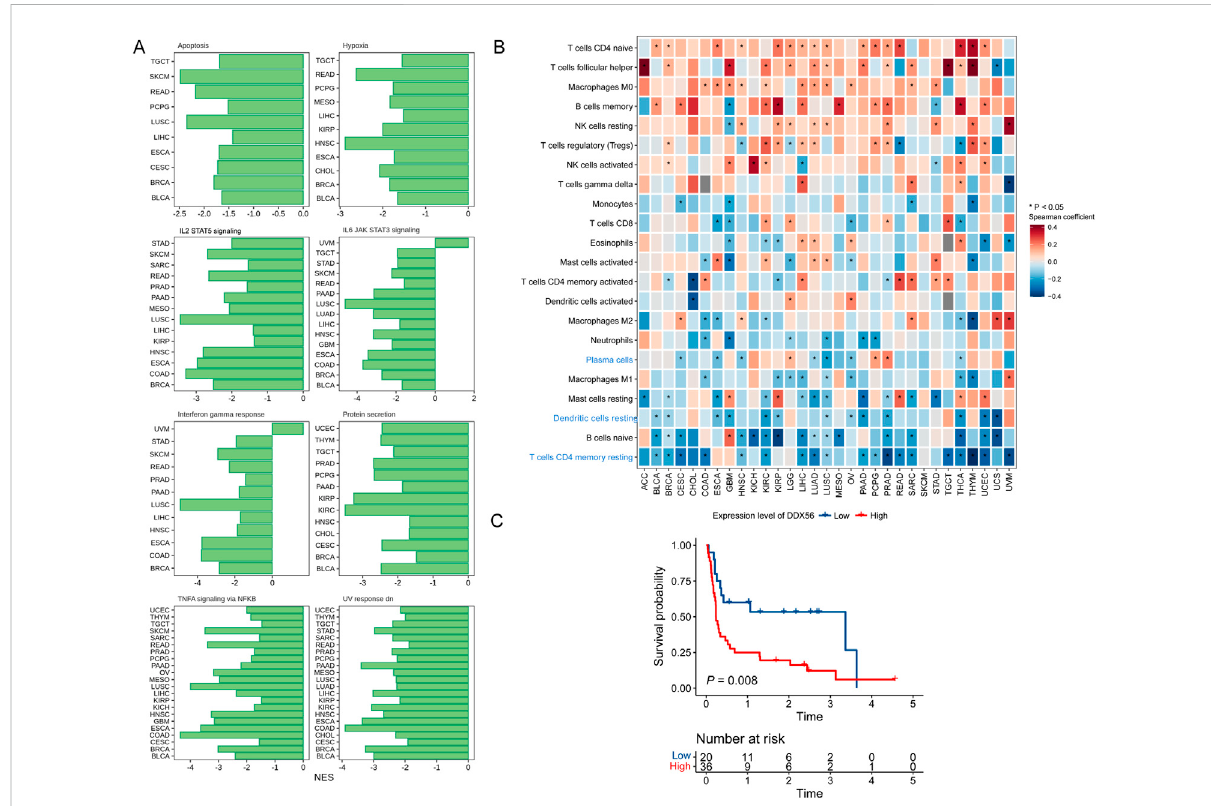
Relationships of DDX56 with tumor immune features. (A) GSEA enrichment results for DDX56 in multiple tumor types. Only pathways deemed signi fi cant enriched based on GSEA ( p < 0.05) are illustrated. (B) Heat map showing Spearman coef fi cients for DDX56 RNA expression and proportions of tumor-in fi ltrating immune cells. (C) Kaplan – Meier plots showing worse clinical outcome in immunotherapy cohort patients with higher expression of DDX56 . Univariate Cox regression was used to assess the